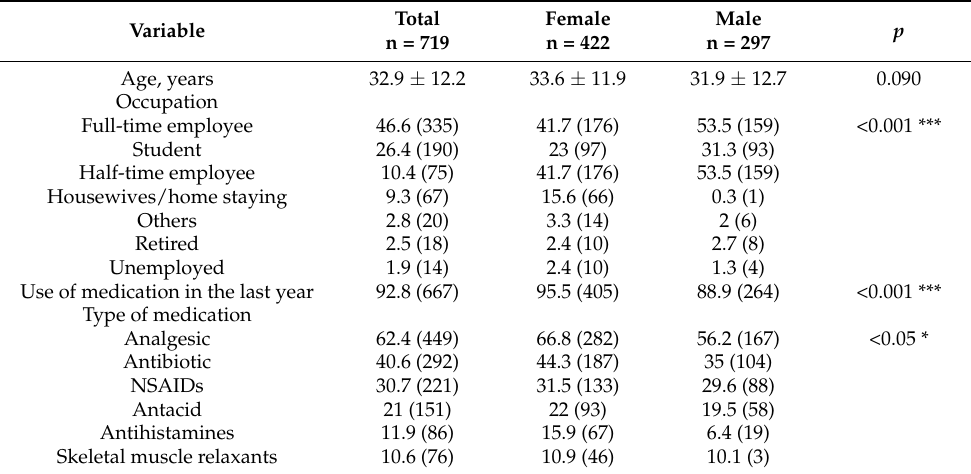
Table 1. Characteristics of the sample of participants living in Mexico City and the metropolitan area according to